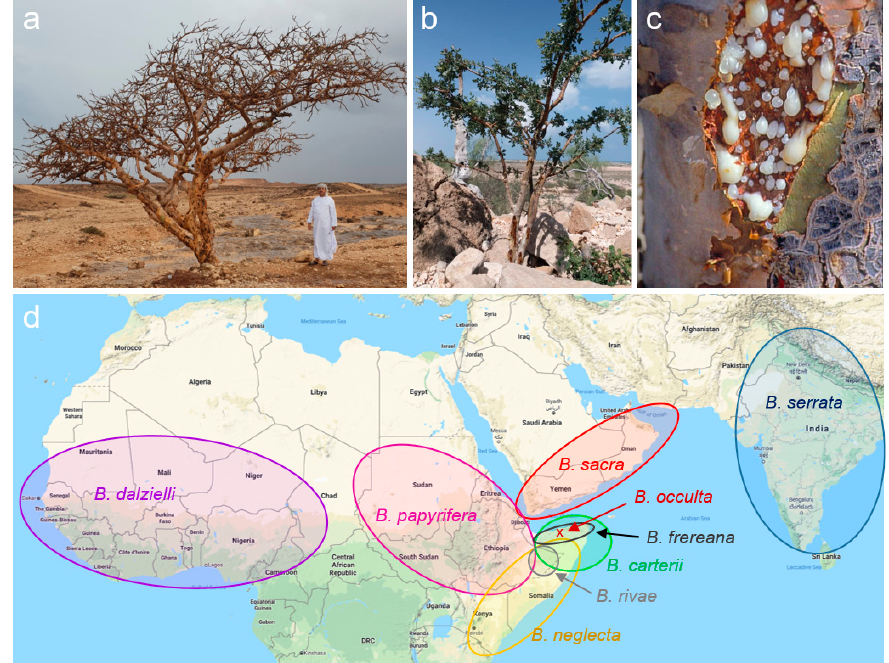
Figure 1. Boswellia trees and their areas of distribution. ( a ) B. sacra tree growing in the dry regions of Oman. ( b ) Trees of the species B. frereana prefer rocky terrains of Somalia. ( c ) Production of frankincense, the oleogum resin of Boswellia trees. ( d ) The growth regions of Boswellia spp. extend from West Africa to India. A particular biodiversity prevails at the Horn of Africa, in and near Somalia. Pictures reproduced with permission of Georg Huber [13]. Map data ©2020 Google, ORION-ME.